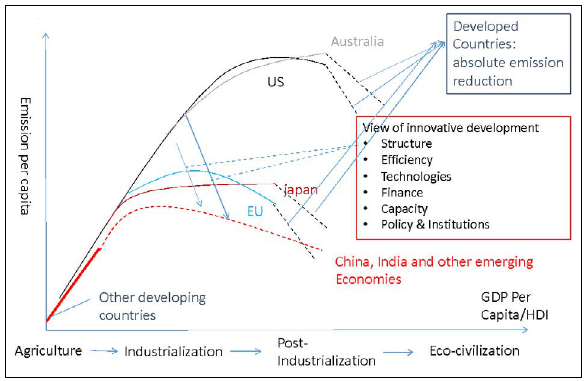
A perspective on global innovation of development